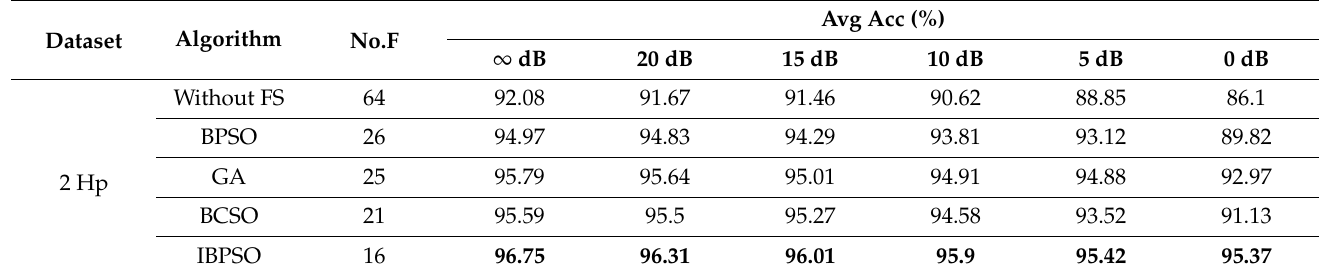
Table 14. Classification results using